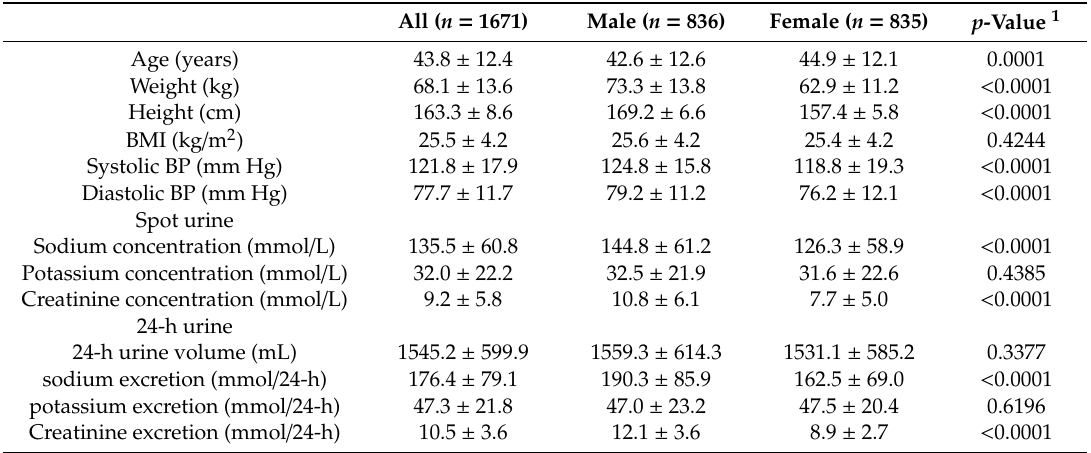
Table 1. Characteristics of the 1671 participants according to gender, mean, and standard